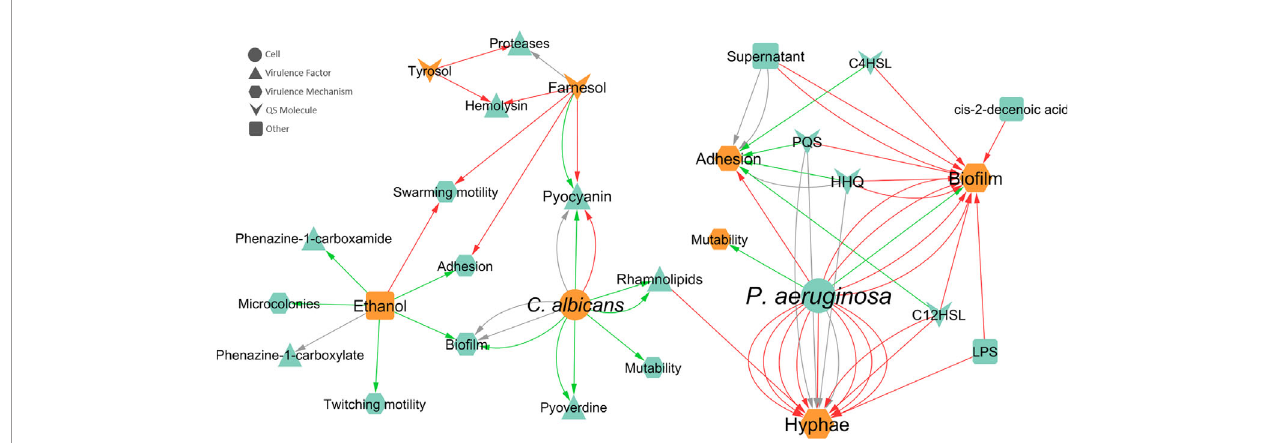
FIGURE 5 | Network of the effects of P. aeruginosa - C. albicans interactions on VF and VM. Teal nodes, P. aeruginosa ; orange nodes, C. albicans ; green arrows, stimulation; grey arrows, null effect; red arrows: inhibition; node and node label sizes are directly proportional to the number of related (outward and inward) edges